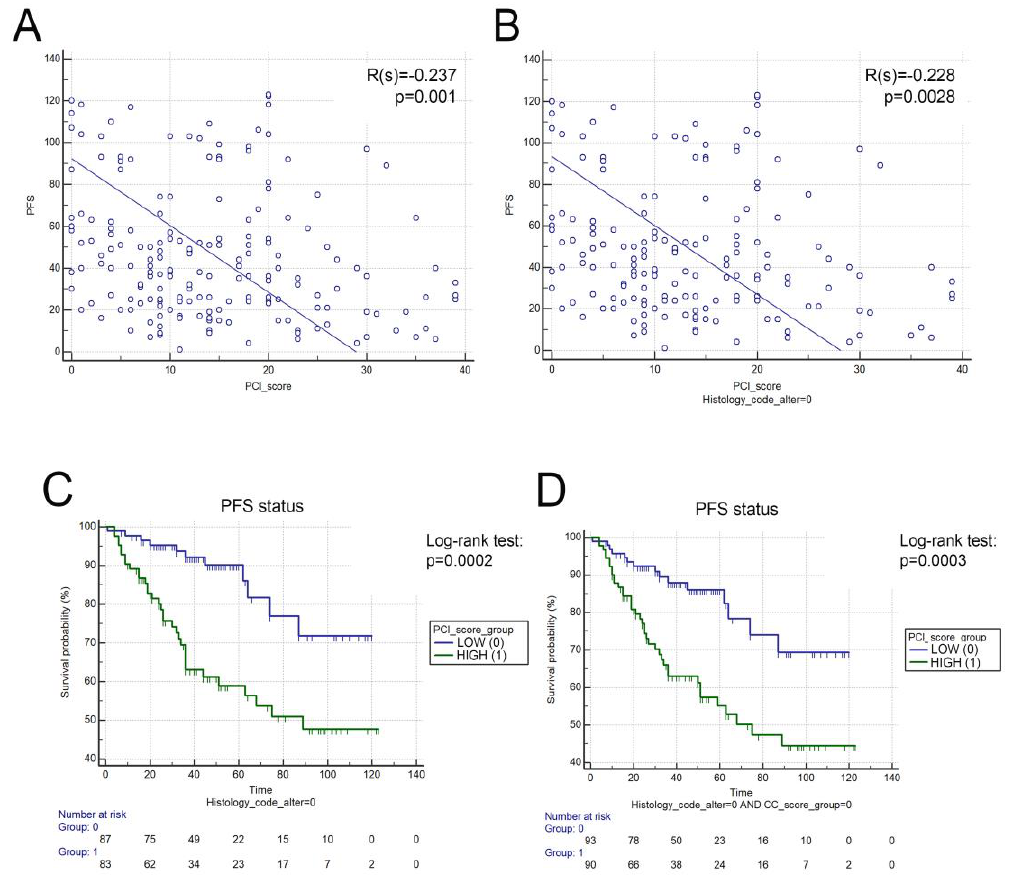
Figure 4. Predictive role of PCI in LAMN. PCI showed a significant, but weak negative correlation with PFS in the whole cohort and in LAMN patients. Low-PCI patients exhibited significantly increased PFS (compared to high-PCI patients), when evaluating all LAMN patients (101.95 vs. 76.88 months, p = 0.0002, E) and only LAMN patients with CC0 situation (98.51 vs. 74.06 months, p = 0.0003, F). Months for OS and PFS are described as